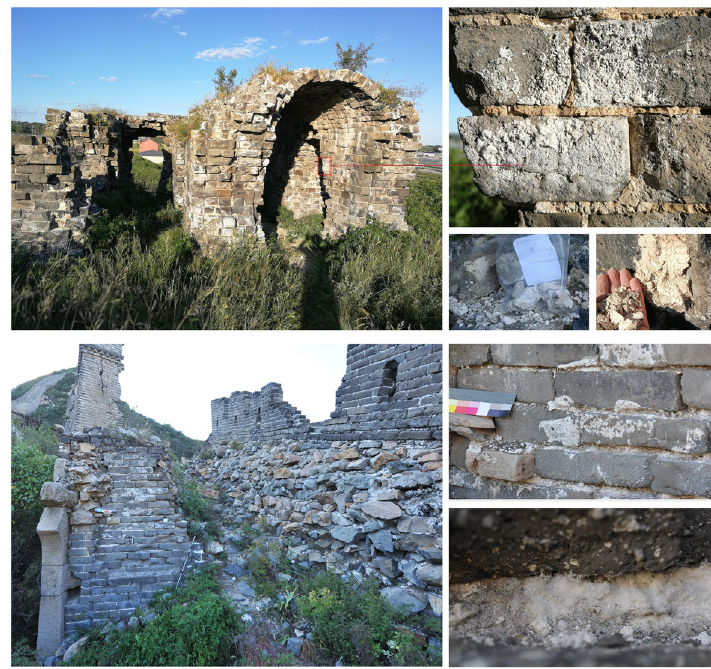
Fig. 15 Parts of the Ming Great Wall are undergoing heavy effloresence. Top: Shanhaiguan ruins, Hebei province. Bottom: ruin of a watch tower made of stone brick in Badaling (Source: